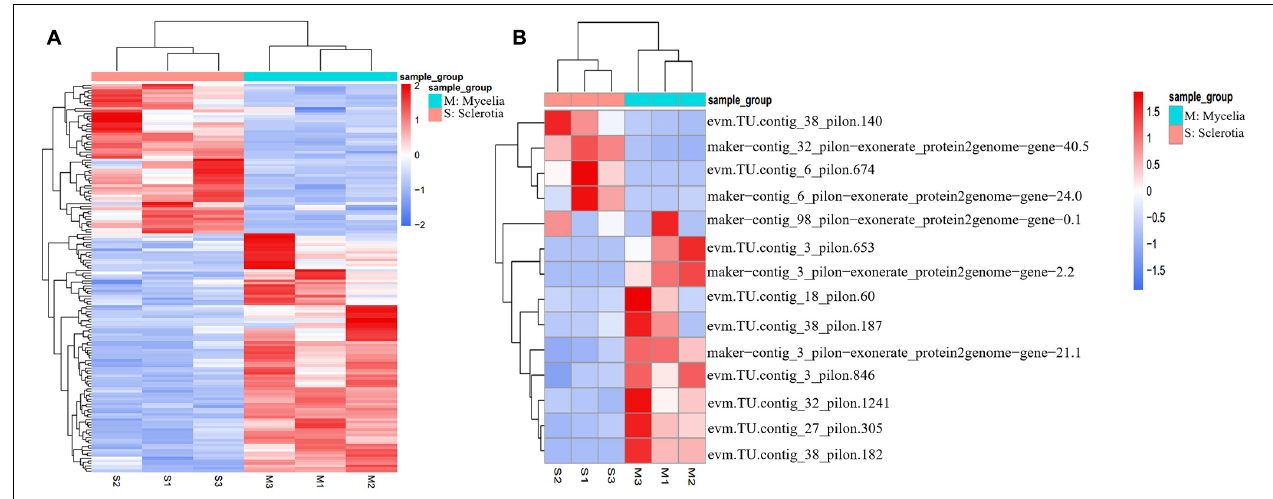
FIGURE 5 | Heat map demonstration of expression patterns analysis in DEGs ( p value < 0.05, | log 2 Fold Change| > 1) between sclerotia and mycelia using the FPKM. (A) Genes involved in oxidation-reduction progress show significant different expression in GO-BP. (B) Hydrophobins had more significant differential expression in sclerotia than in mycelia.